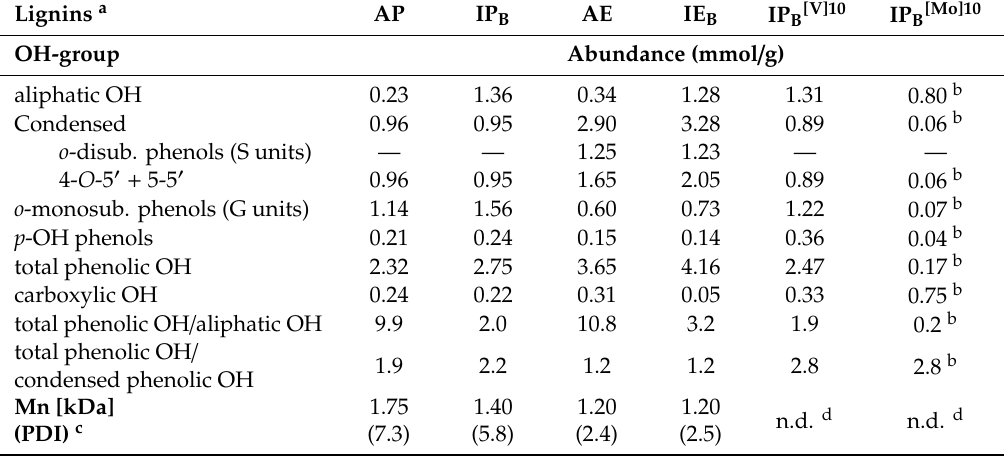
Table 1. Distribution of OH-groups and molecular weight key data of acetosolv and ionosolv lignins tested for oxidative